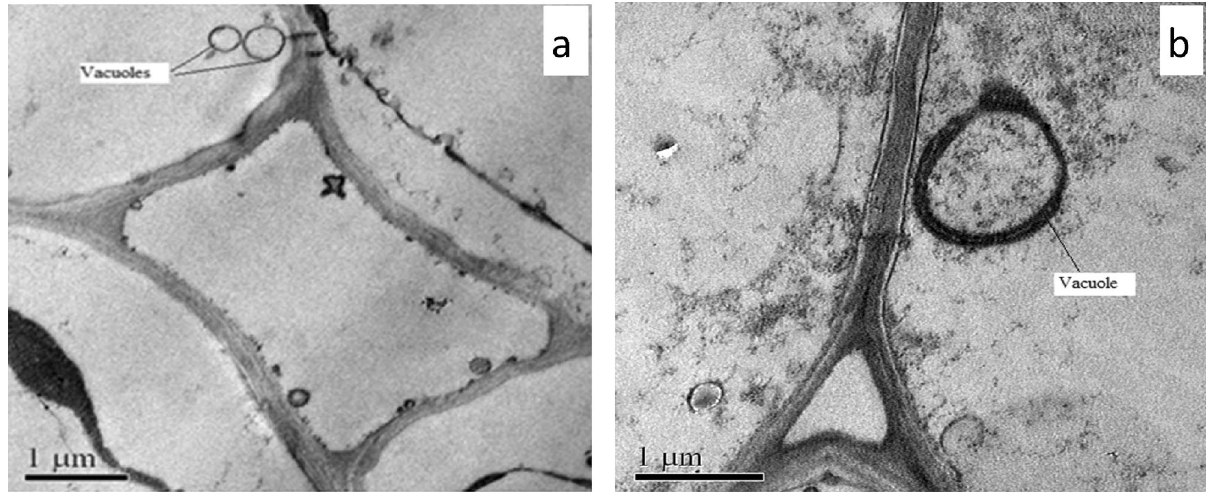
Figure 7. TEM micrographs of transverse section of roots of T. natans : ( a ) control plant root showing the vacuoles, ( b ) Sb treated plant root showing metal/metalloid precipitation within the vacuole.